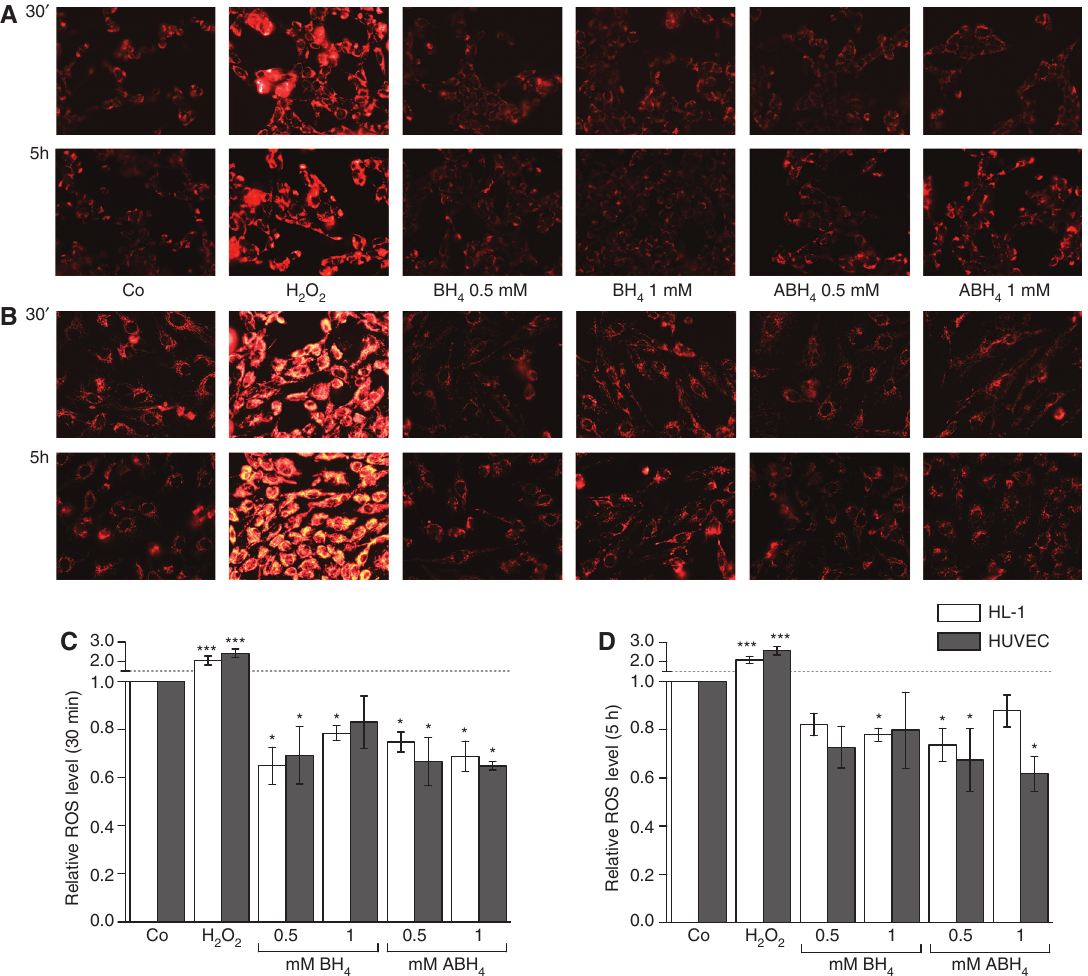
and ABH treatment on basal mitochondrial ROS levels. HL-1 cells and HUVECs were treated with 0.5 mM or 1 mM Figure 3 Effects of BH 4 4 of BH or ABH for 30 min or 5 h. Mitochondrial ROS levels were assessed by fluorescence microscopy during early reoxygenation ( ≤ 5 min). 4 4 Representative fluorescence images are shown for HL-1 cells (A) and HUVECs (B). (C and E) Summary bar graphs of BH basal ROS levels in HL-1 cells and HUVECs after 30 min (C) and 5 h (D). H (Co) was set to 1.0. Data are expressed as mean ± SD (n = 3, *p < 0.05, ***p < 0.001 vs. control).